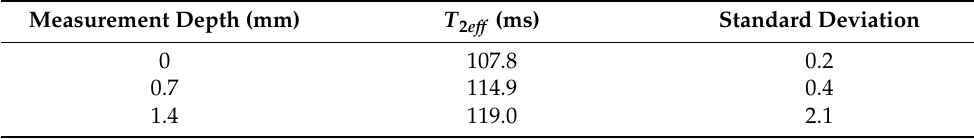
Table 5. Values of T 2 eff in the aging test at different depths.